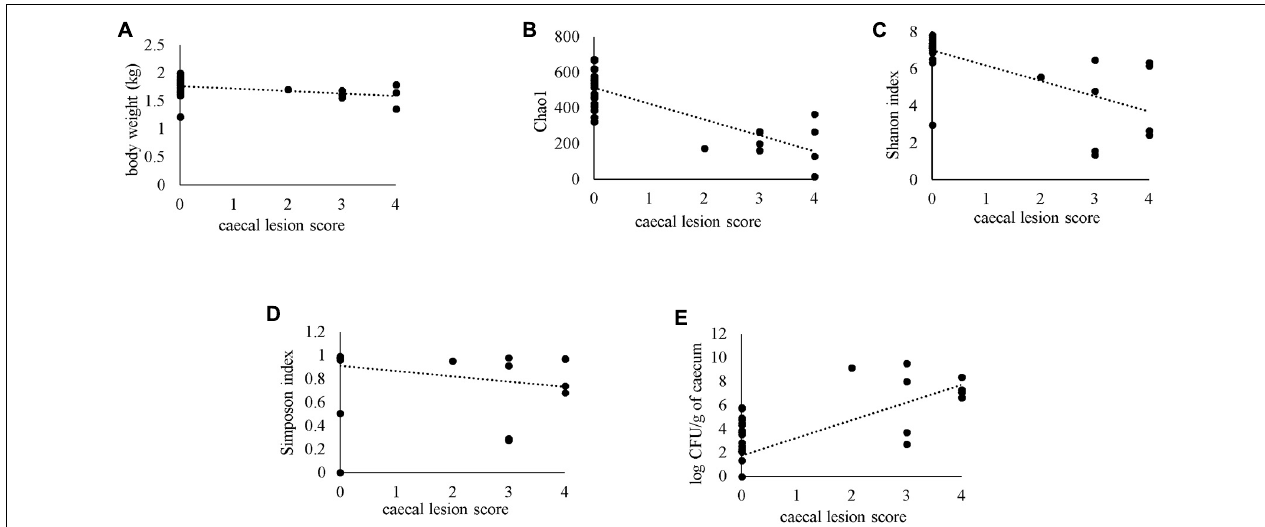
FIGURE 12 | Spearman’s rank correlation of macroscopic cecal lesion score with body weight (A) , alpha diversity metrics in the caeca (B–D) or bacterial load of lux -tagged E. coli in the cecum (E)